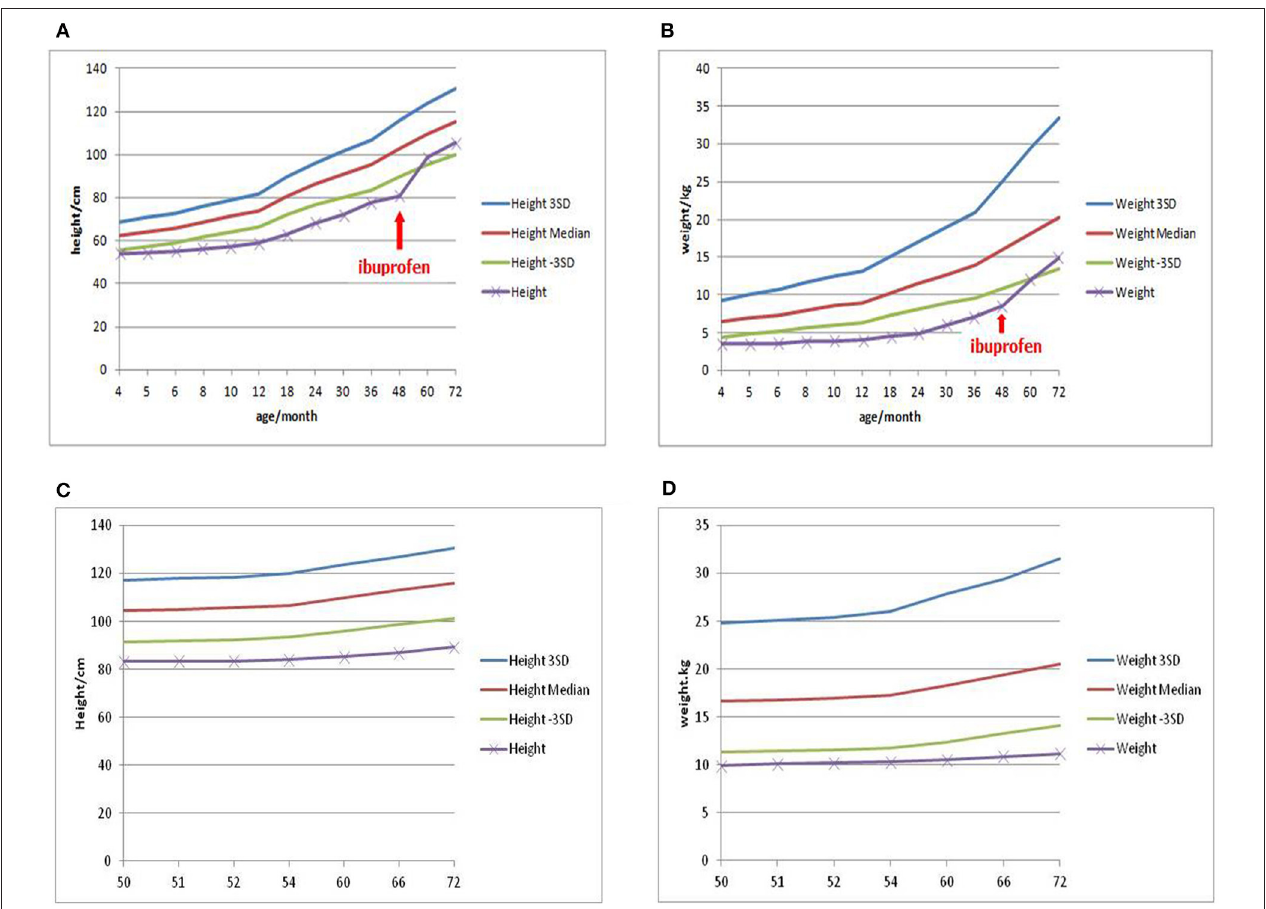
FIGURE 1 | Growth curve of patient 1 showed the effect of ibuprofen in improving weight and height (A,B) , while Growth curve of patient 2 showed persistent growth retardation (C,D)